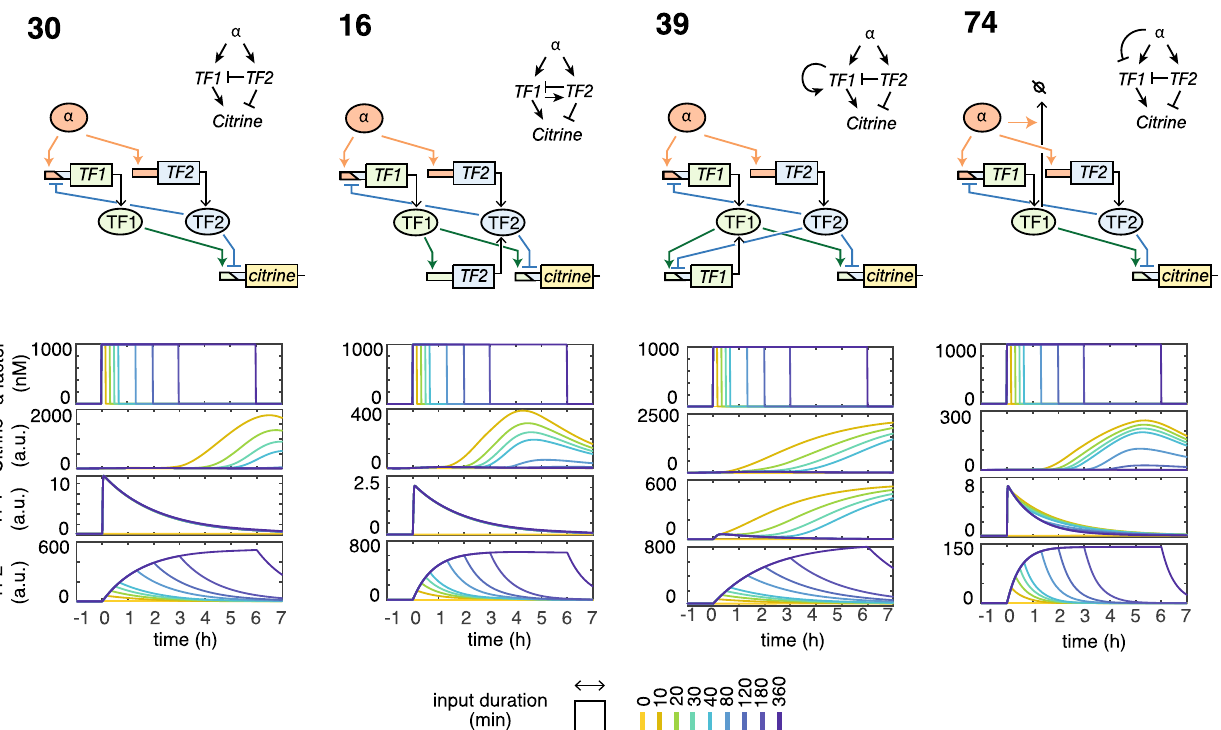
Fig. 2 Decoder design principles. Detailed (colors; see Fig. 1) and abstracted (black) topologies of four simple functional circuits (top; numbers indicate topology variants). Internal dynamics of TF1 and TF2 were simulated for a random viable parameter sample for each circuit, with different input ( α -factor) durations (indicated by colors;